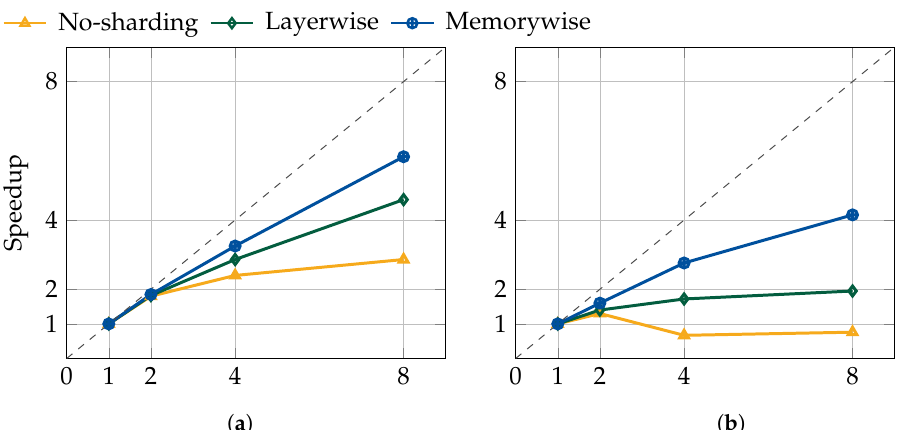
Figure 6. Effects of parameter sharding techniques on the training performance of SHAT ; ( a ) ResNet- 50; ( b )